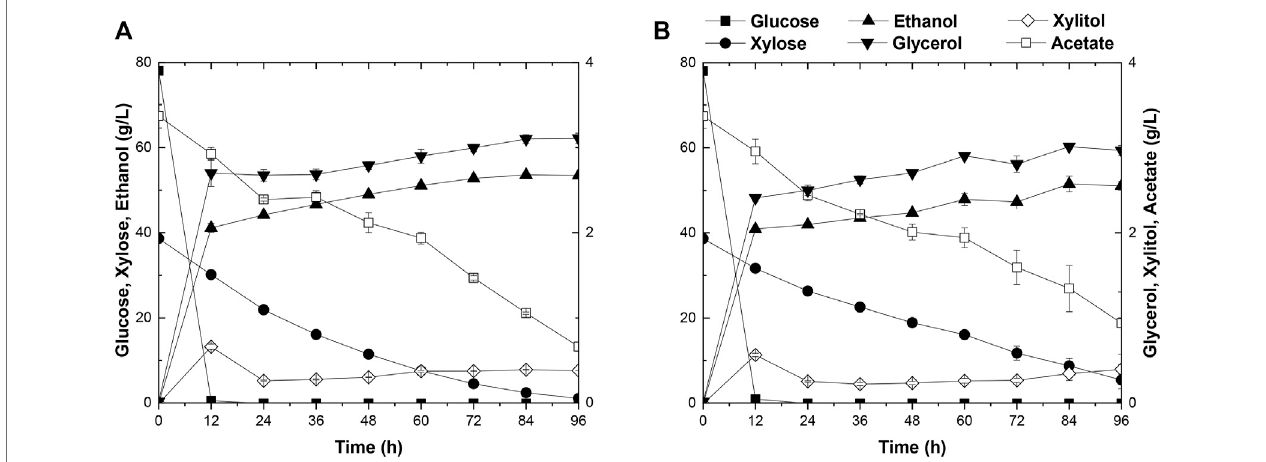
FIGURE2| Time-dependentethanolfermentationofstrainsA21ZandA22ZinYPmedium.Fermentationpro fi leofA21Z (A) andA22Z (B) inYPmediumwith3 g/L acetate, 80 g/L glucose, and 40 g/L xylose.